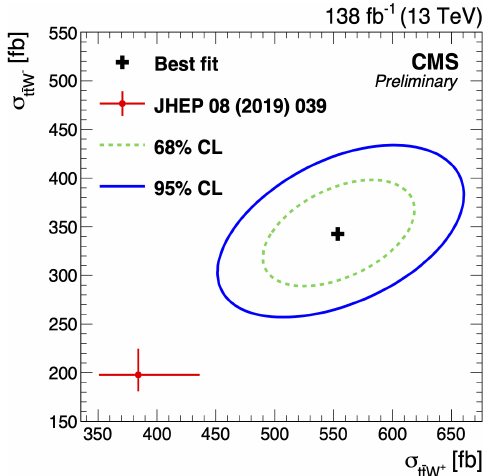
Figure 13. Contours showing the 68% and 95% CL intervals from the likelihood fit in which the t¯tW + and t¯tW − processes are measured simultaneously as independent parameters [41]. The best fit value of the fit is indicated by the black cross, with the theory prediction from Ref. [31] shown by the red cross. The theory prediction included is without the FxFx jet merging.